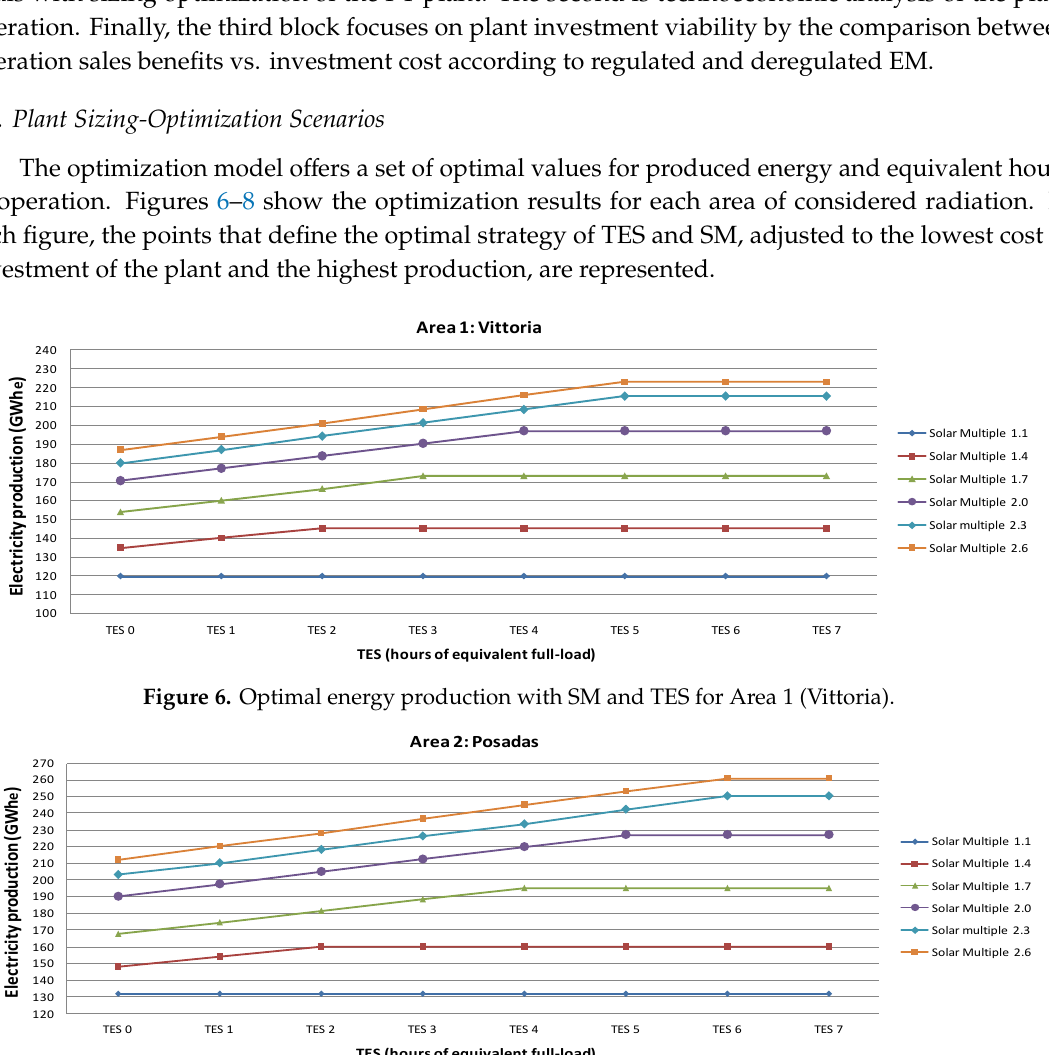
Figure 7. Optimal energy production with SM and TES for Area 2 (Posadas).